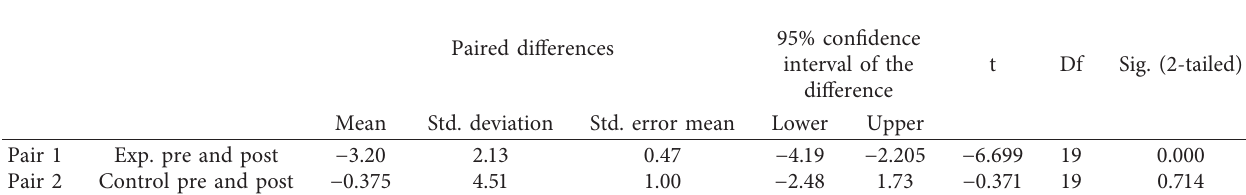
Table 7: Results of paired sample t